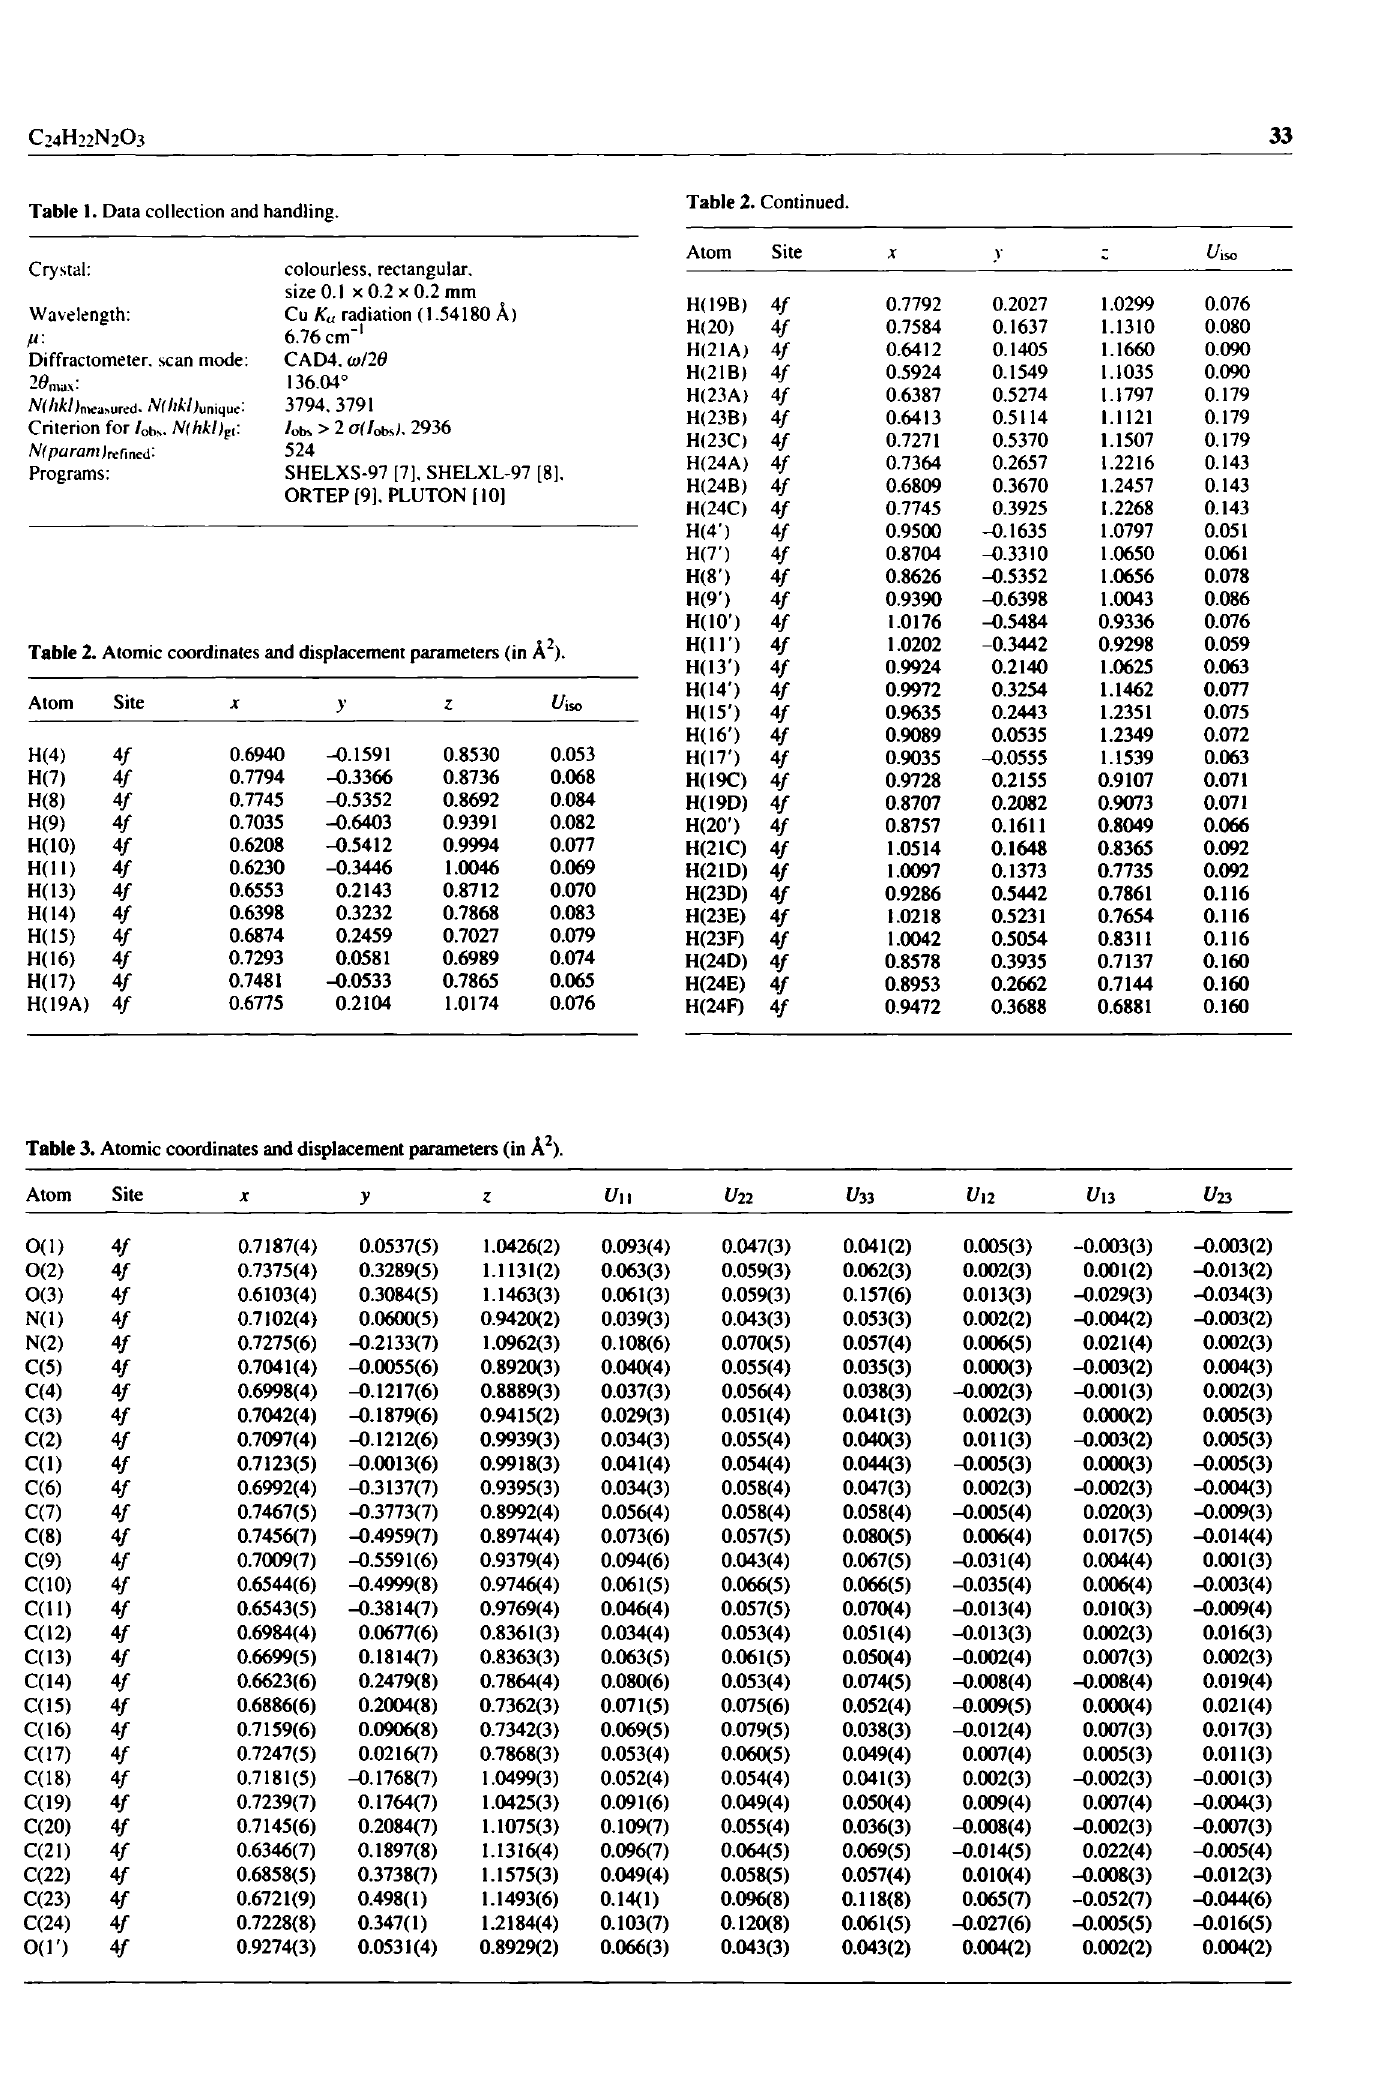
Table 2. Atomic coordinates and displacement parameters (in À 2 ).